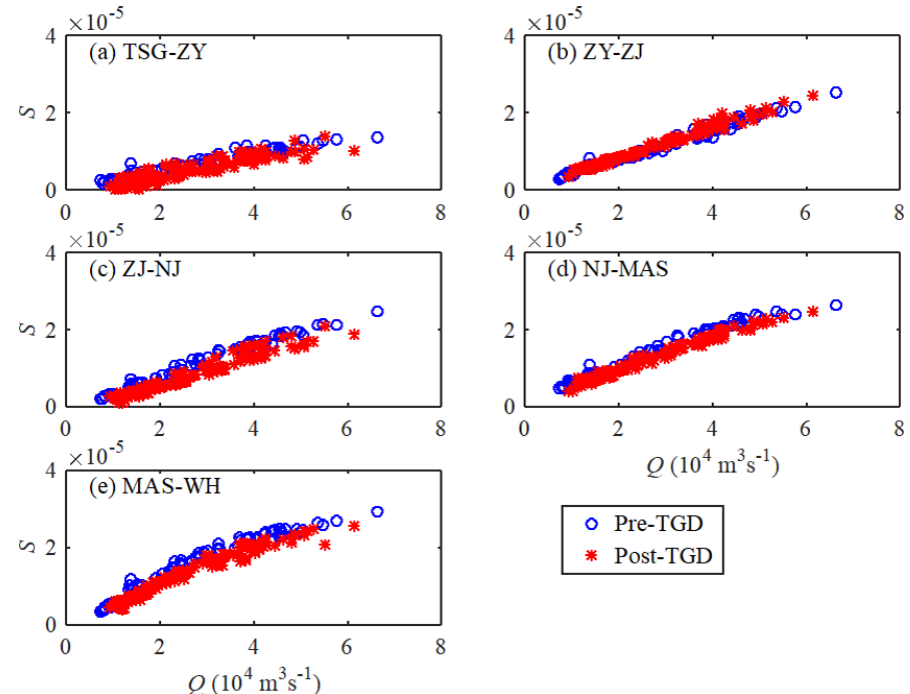
Figure 4. Changes in residual water level slope S before and after the TGD closure for different reaches along the Yangtze estuary: (a) TSG-JY, (b) JY-ZJ, (c) ZJ-NJ, (d) NJ-MAS, and (e)